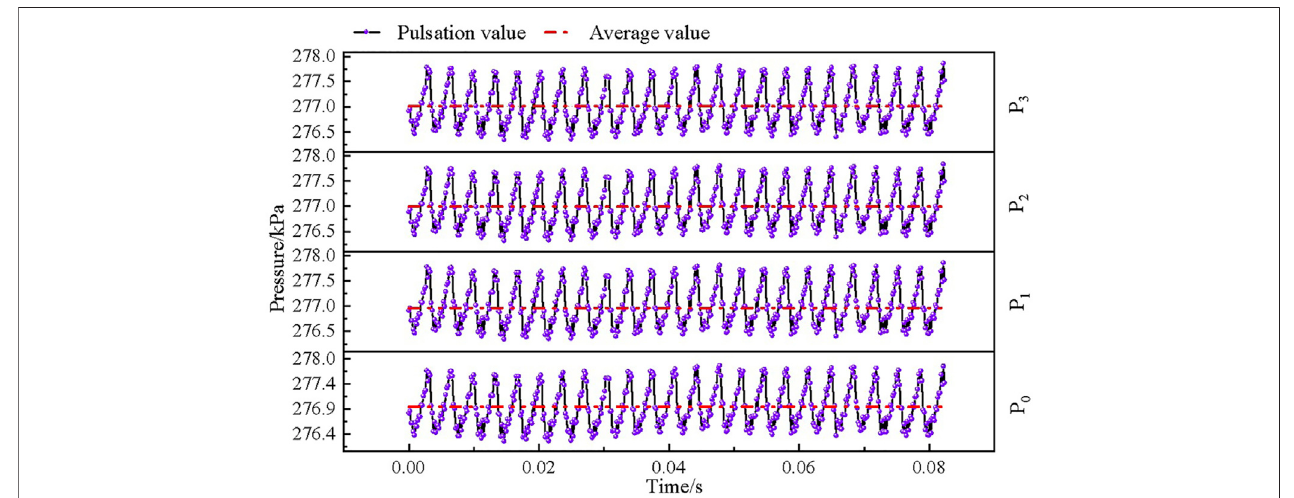
FIGURE 7 | Time domain diagram of pressure pulsation under rated operating conditions.